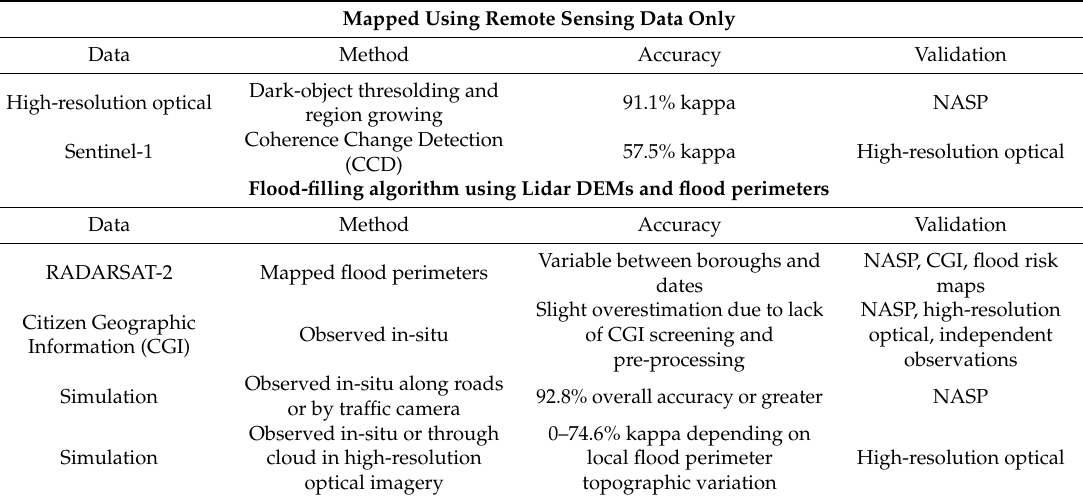
Table 6. Summary of methods and results from presented case